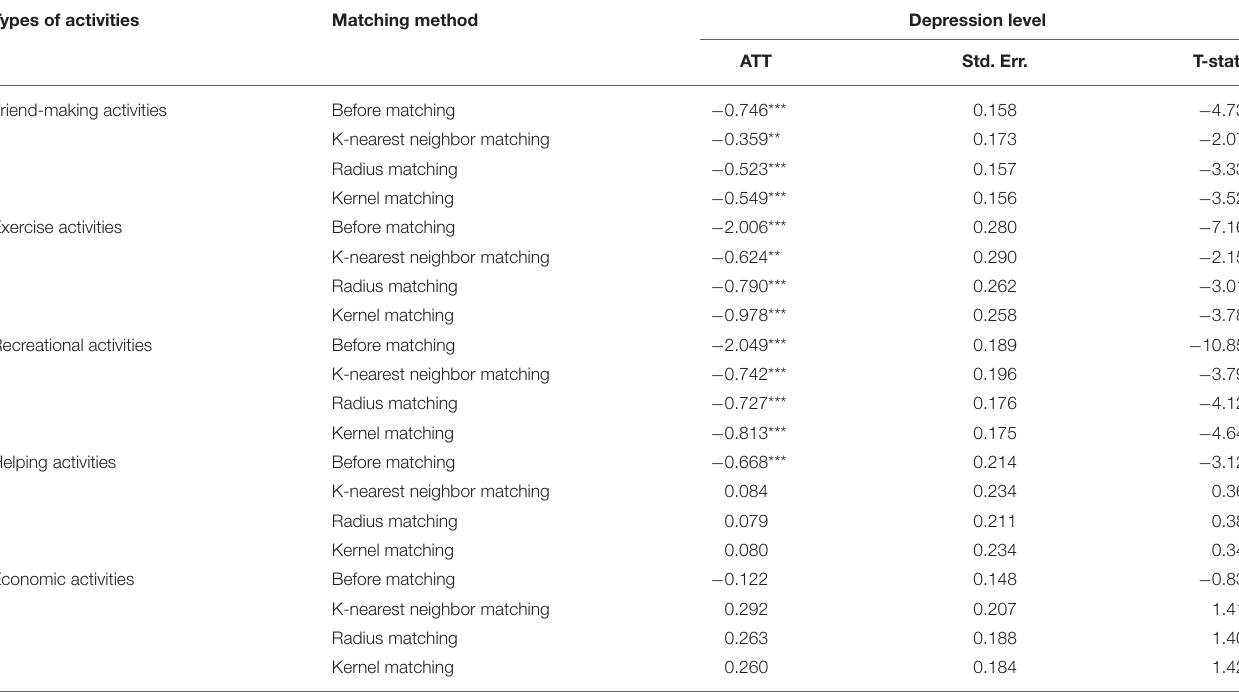
TABLE 5 | ATT of participating in five types of social activities on depression in the elderly. Types of activities